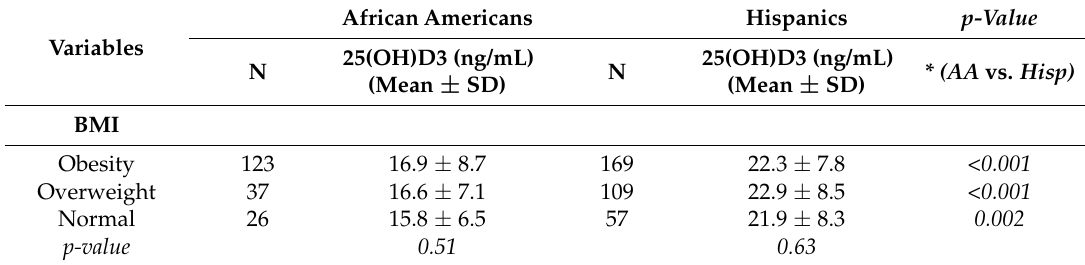
Table 3. 25(OH)D3 level by cancer, age and obesity between African Americans and Hispanics.